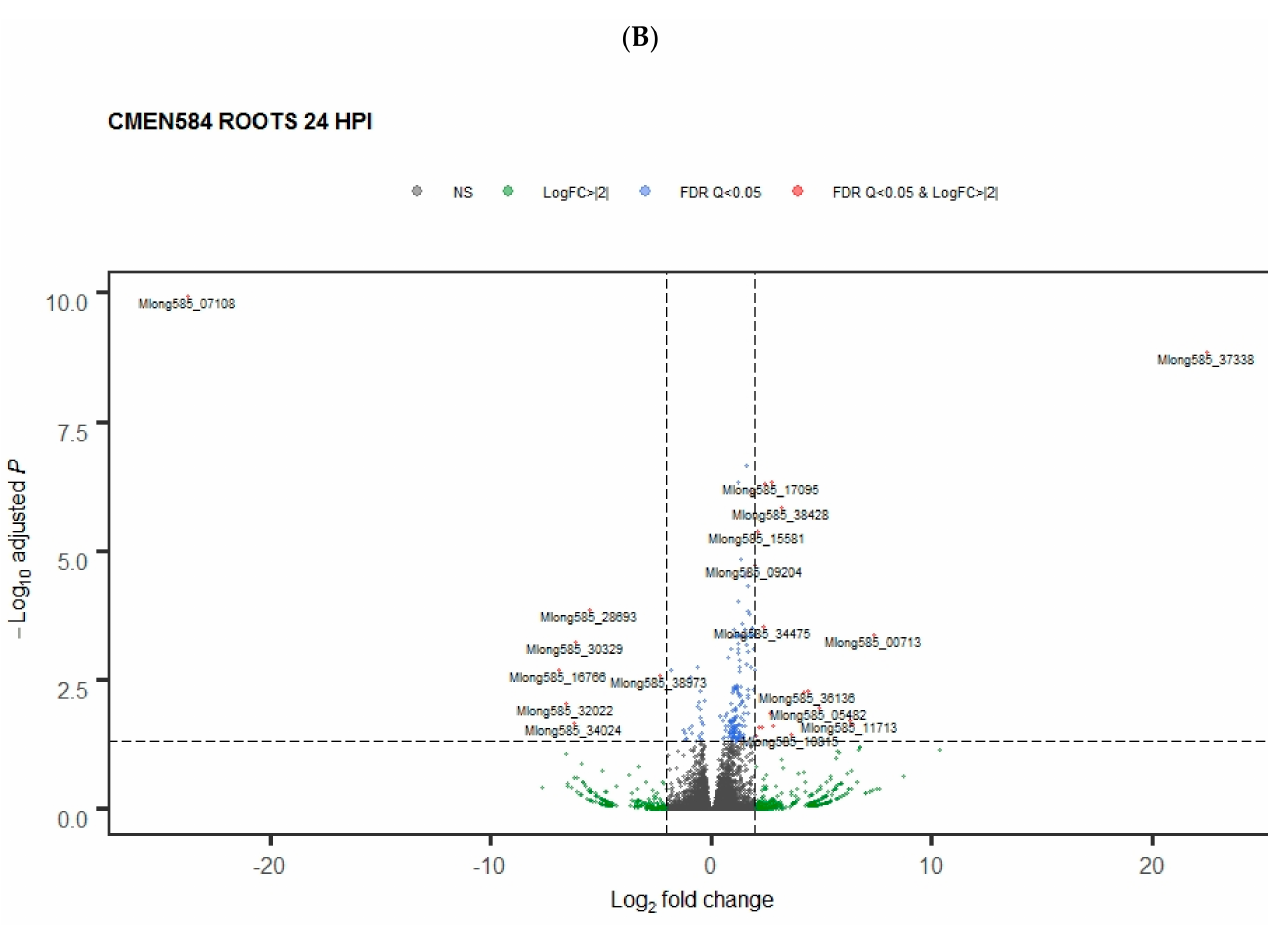
Figure 2. More genes are differentially regulated in roots of CMEN 585 than in roots of CMEN 584 early after exposure to V. dahliae . The volcano plots show genes that are significantly upregulated or downregulated (red data points) in ( A ). Resistant M. longifolia CMEN 585 and ( B ) susceptible CMEN 584 at 24 h post-inoculation with V. dahliae